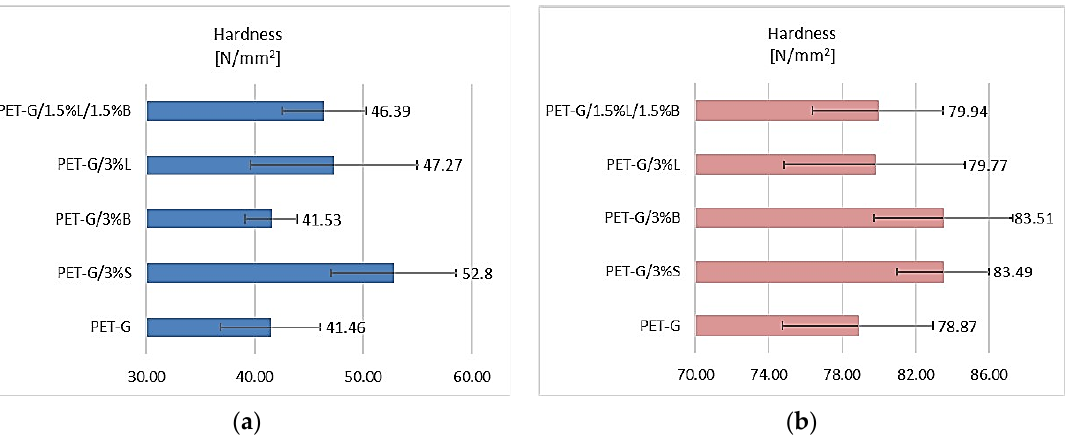
Figure 4. Hardness test results of ( a ) samples obtained by 3D printing and ( b ) samples obtained by injection molding.